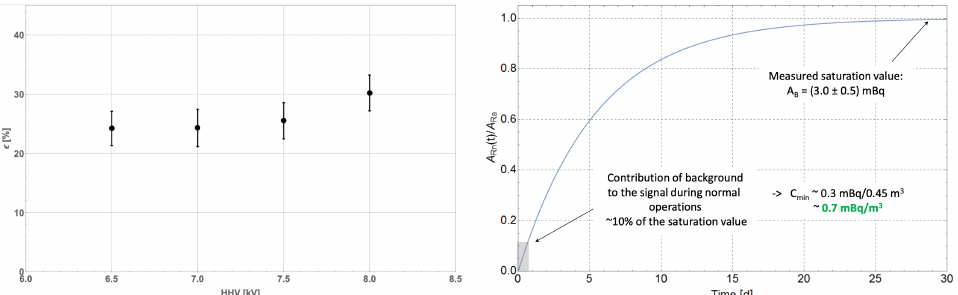
Figure 6. Left : Overall measured detection efficiency of the ERM for the 218 Po and 214 Po peaks as function of the operational voltage, HHV (High High Voltage). Right : The activity of radon emanated from the ERM detector (in saturation).